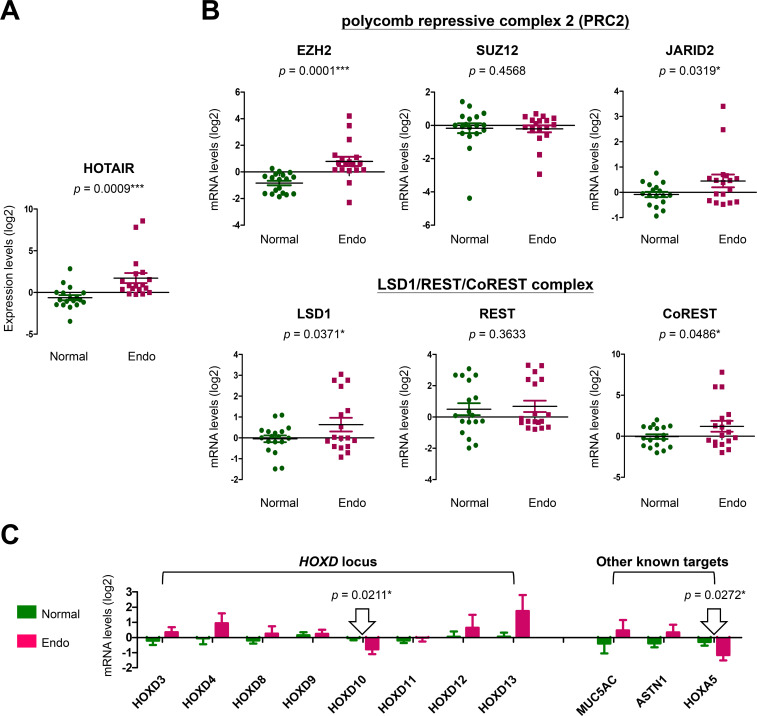
HOTAIR expression and its association with endometriosis development.Microarray data (GSE120103) from the GEO databank was utilized for clinical association study. (A) HOTAIR levels in lesions from severe endometriosis patients (stage 4) (Endo; n = 18) were analyzed and compared with that in normal endometria (Normal; n = 18). (B) Expression levels of component genes in HOTAIR-associated complexes, PRC2 and LSD1/REST/CoREST, were also analyzed and compared with the levels in healthy controls. (C) Expression levels of possible downstream effectors of HOTAIR, including genes at the HOXD locus and other validated targets [17,28], were compared between patients (Endo) and controls (Normal) by using t-test.